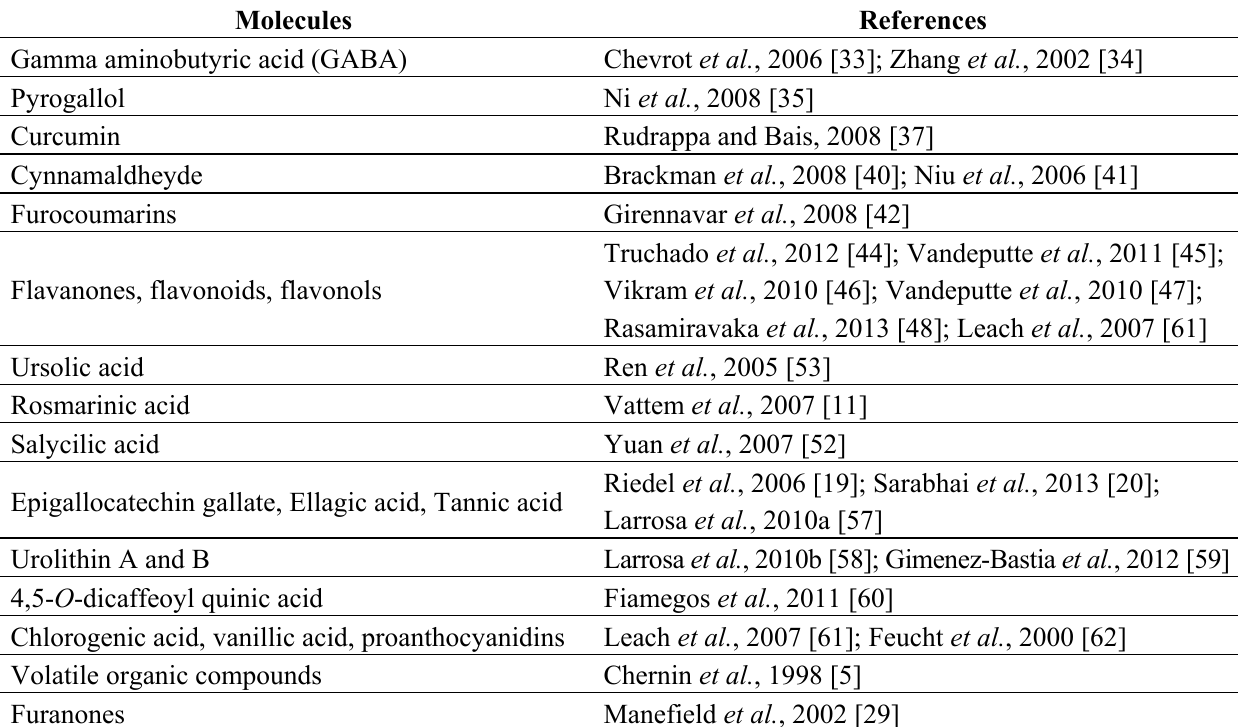
Table 1. Phytochemicals with proved antiquorum sensing